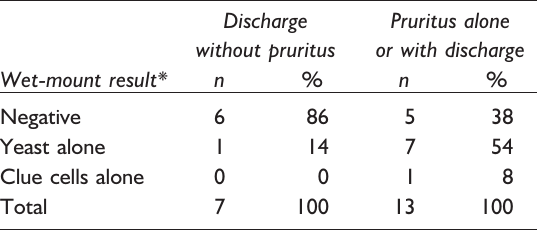
Table 3 The relationship between type of symptoms and microscopy in 20 symptomatic cases with normal pH